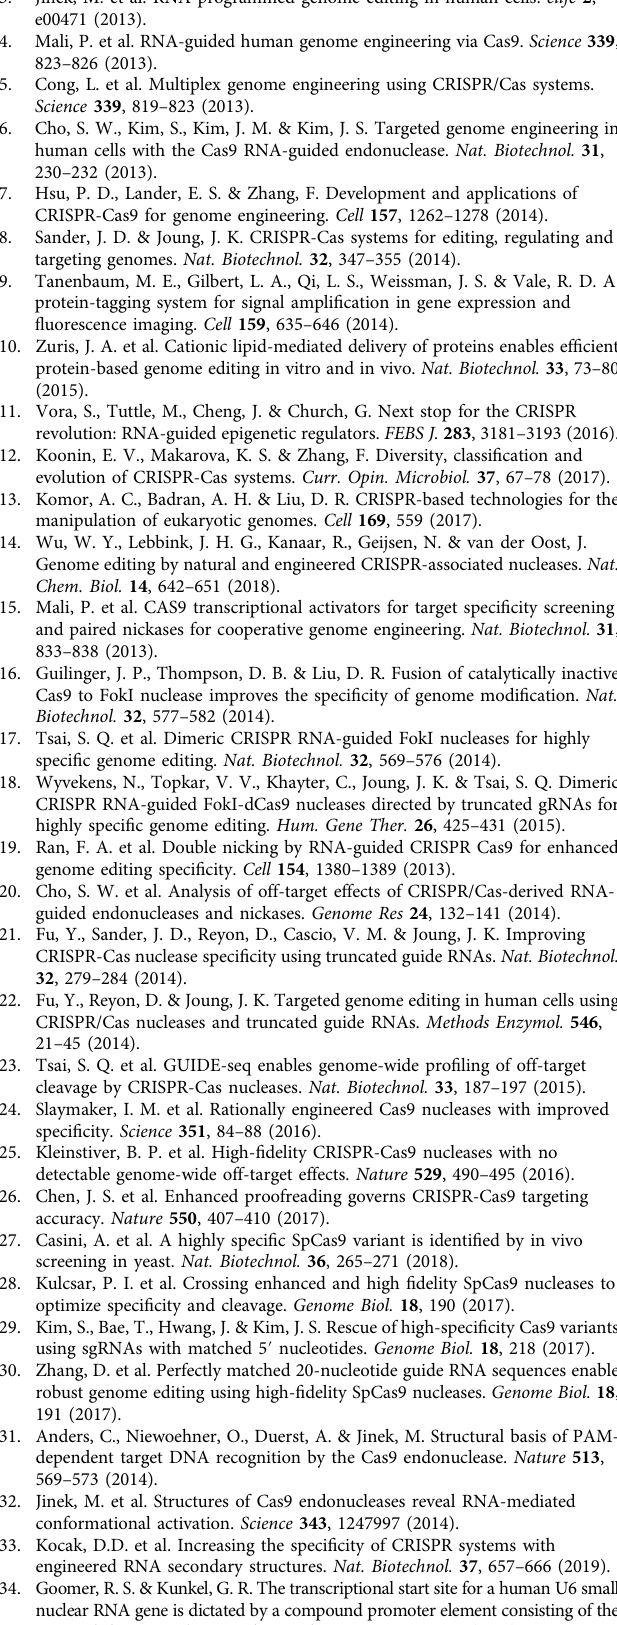
Fig. 2b: evoSpCas9/B-evoSpCas9; Fig. 3a: evoSpCas9/B-evoSpCas9, HeFSpCas9/B- HeFSpCas9; Supplementary Fig. 8f: eSpCas9-ribosyme/eSpCas9-tRNA) or by using Wilcoxon Signed Ranks test(Fig. 2a: SpCas9-HF1/B- SpCas9-HF1, HypaSpCas9/B- HypaSpCas9, evoSpCas9/B-evoSpCas9, HeFSpCas9/B-HeFSpCas9; Fig. 2b: eSp- Cas9/B-eSpCas9, SpCas9-HF1/B- SpCas9-HF1, HypaSpCas9/B-HypaSpCas9; Fig. 3a: eSpCas9/B-eSpCas9, SpCas9-HF1/B- SpCas9-HF1, HypaSpCas9/B- HypaSpCas9; Supplementary Fig. 4b: WT SpCas9/B-SpCas9; Supplementary Fig. 8f: eSpCas9/eSpCas9- plus , eSpCas9/eSpCas9-ribosyme, eSpCas9/eSpCas9- tRNA, eSpCas9- plus /eSpCas9-ribosyme, eSpCas9- plus /eSpCas9-tRNA) in cases where differences did not meet the assumptions of Paired t -test. Normality of